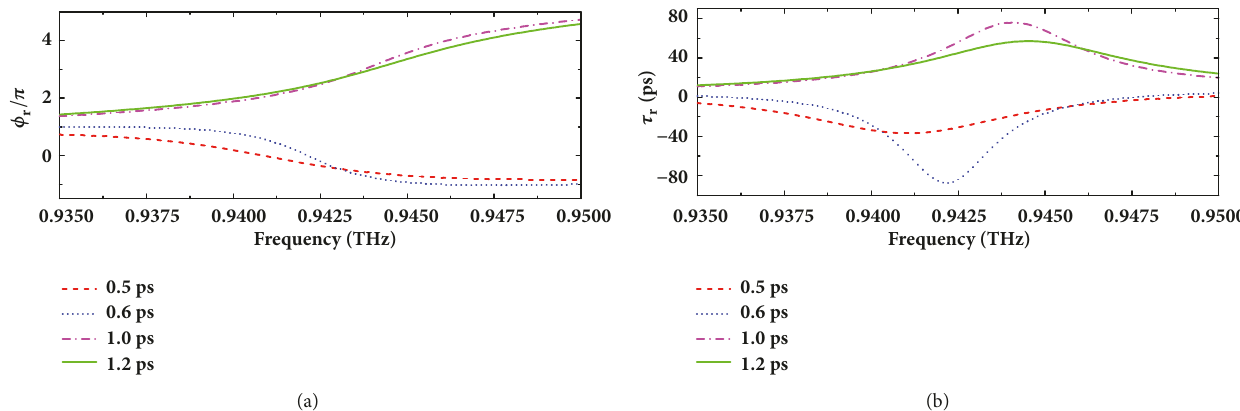
Figure 3: (a) Reflected phase 𝜙 𝑟 and (b) reflected group delay 𝜏 𝑟 as functions of frequency for different relaxation time in the graphene-1D-PC structure. Other parameters are the same as before.